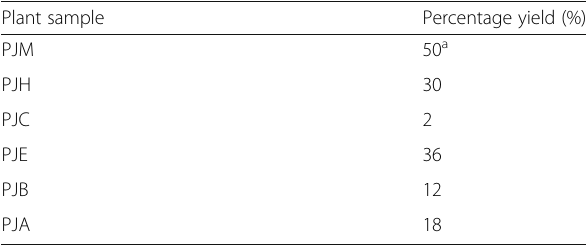
Table 2 Qualitative phytochemical analysis of